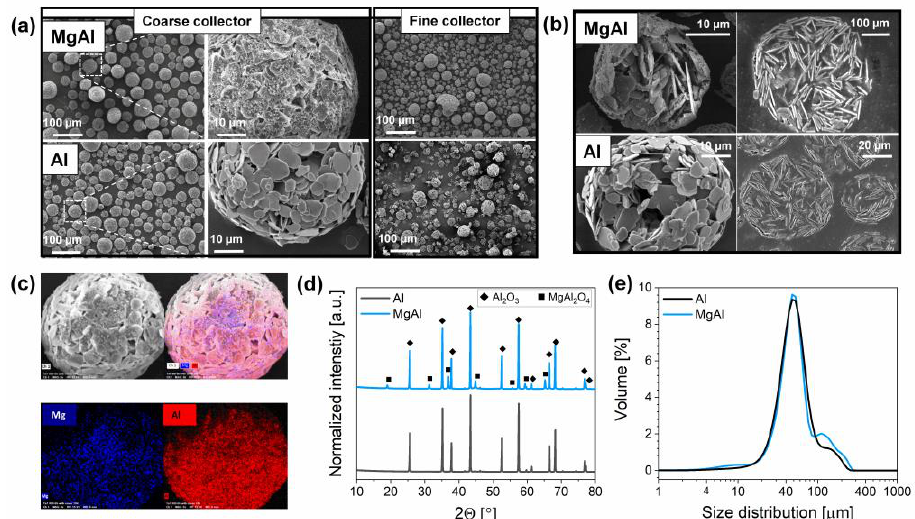
Figure 2. Characterization of the spray-dried Al (—) and MgAl (—) granules that were calcined at 800 °C. ( a ) Electron micrographs, ( b ) sub-surface morphology of the broken (left) or polished (right) granules, ( c ) elemental mapping of MgAl granules, ( d ) X-ray diffractograms, and ( e ) particle size distribution of the granules.